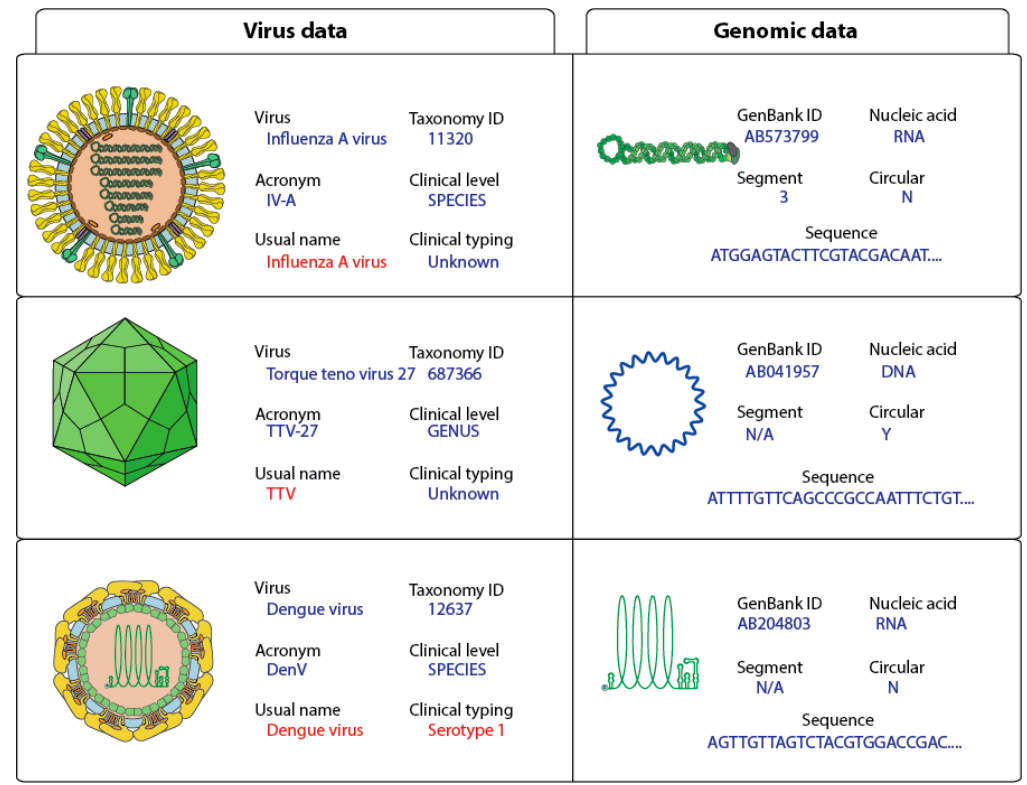
Figure 2. Examples of virus genome annotation. The usual name and clinical typing should be the default output for clinical studies and are shown in red.